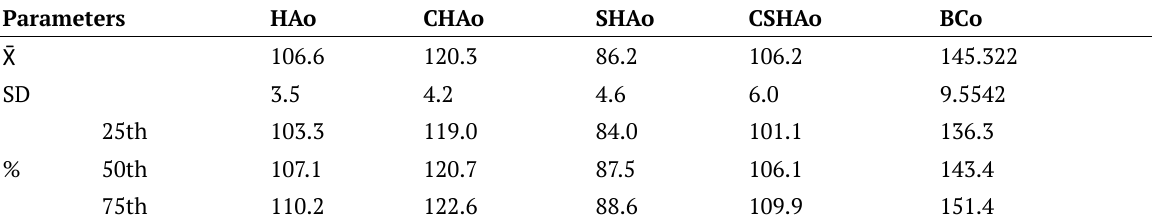
Table 2. Descriptive statistics and level of the angle degree and back curve during cycling